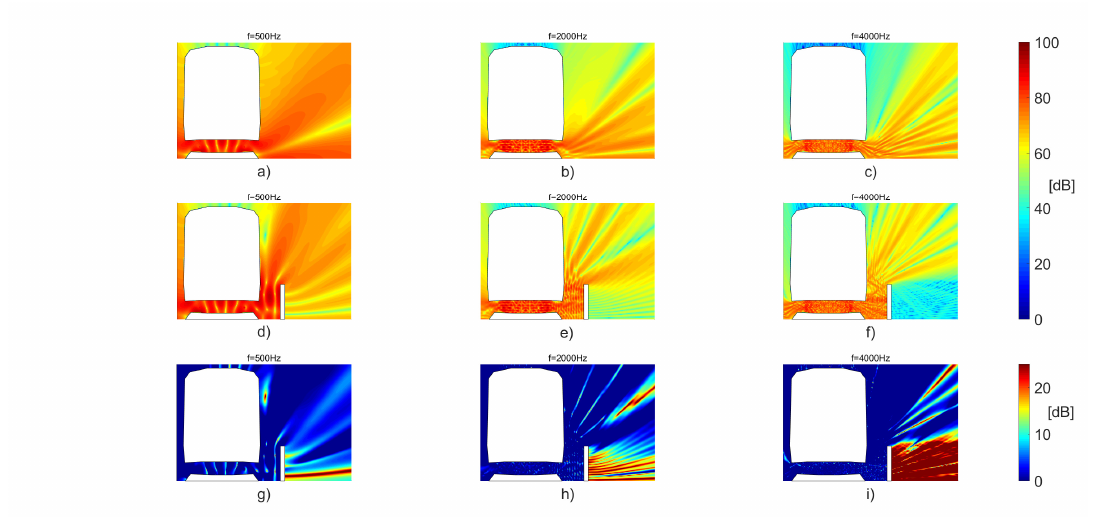
Figure 15. Sound pressure level calculated without ( a – c ) and with ( d – f ) the noise barrier and the insertion loss ( g – i ).